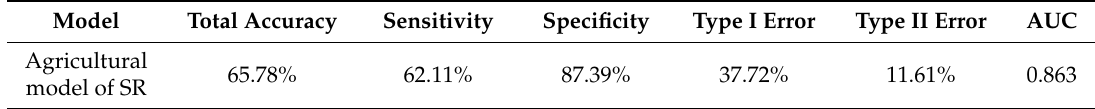
Table 7. Total assessment of the general agricultural model of SR.